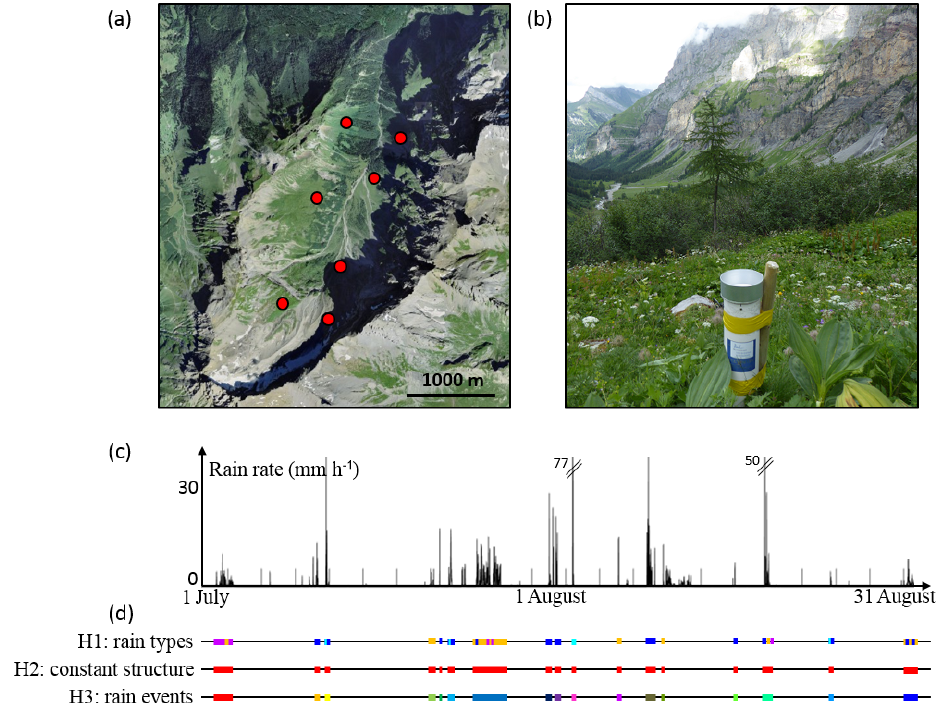
Figure 5. Observation dataset used for validation. (a) Measurement network. Red dots denote rain gauge locations. (b) Picture of a rain gauge with the Vallon de Nant catchment in the background. (c) Observed rain rate averaged over the network. (d) Segmentation of the time axis into stationary periods for the three tested hypotheses. For each hypothesis, segments with the same colour denote periods for which rainfall is expected to have similar space–time